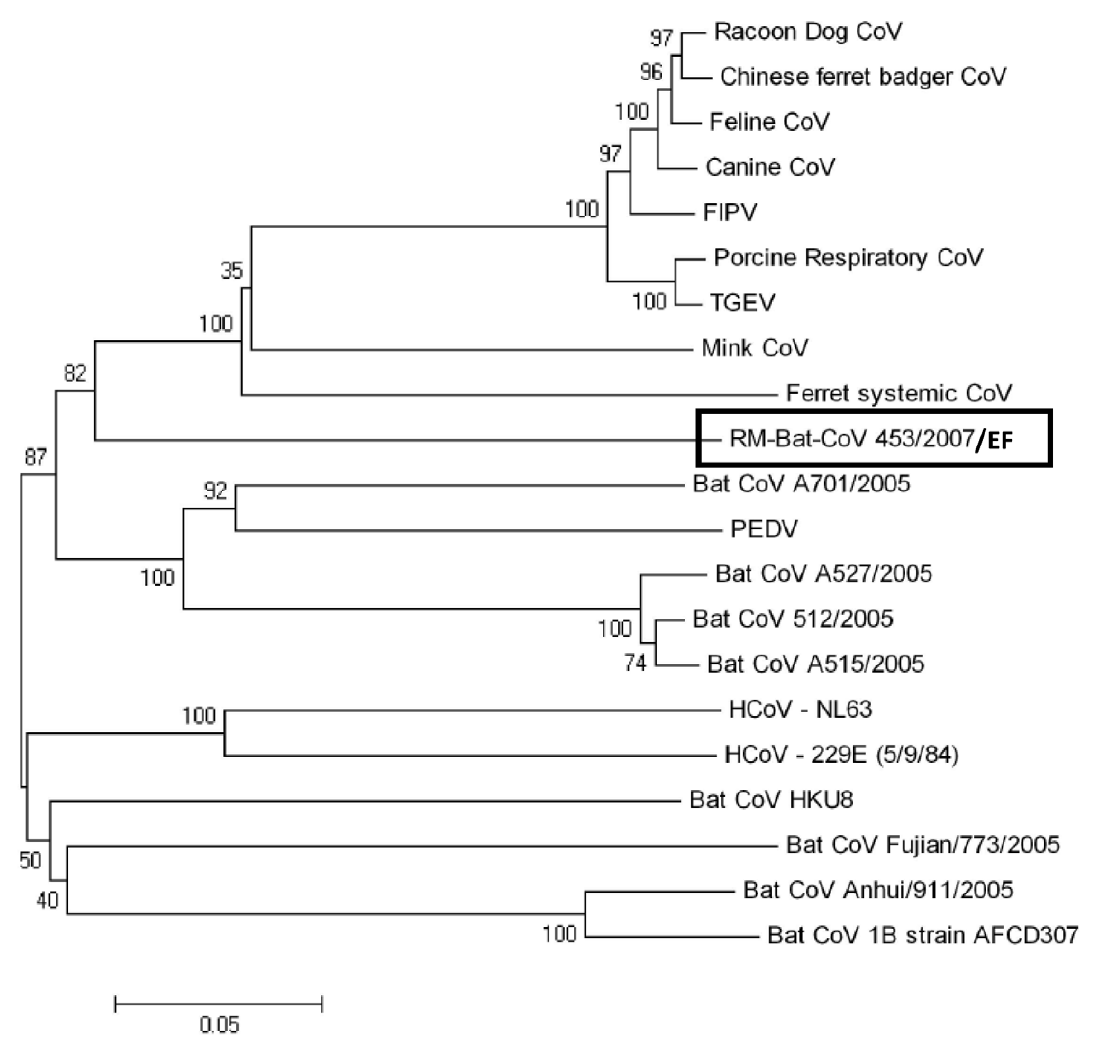
Figure 2. Phylogenetic Analysis of the spike gene. Phylogenetic analysis of an 1100 nucleotide segment of the S2 region of the spike gene of RM-Bat-CoV 453/2007/EF ( Eptesicus fuscus ) compared to other known alphacoronaviruses. Phylogenetic trees were constructed by the neighbor- joining method using MEGA version 4.